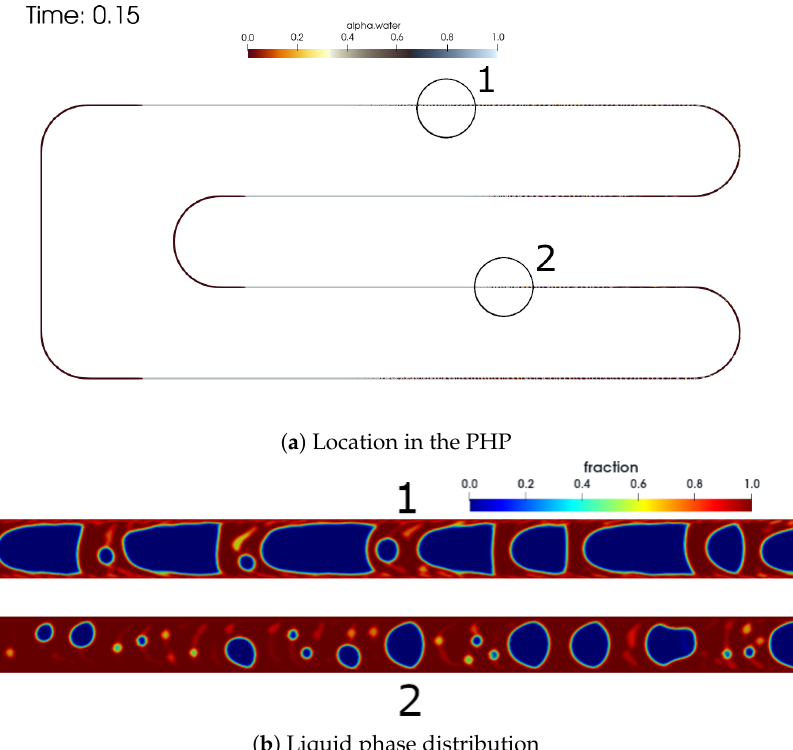
Figure 23. Numerical results of the Xu model [29] in 0.15 s for 100 W input